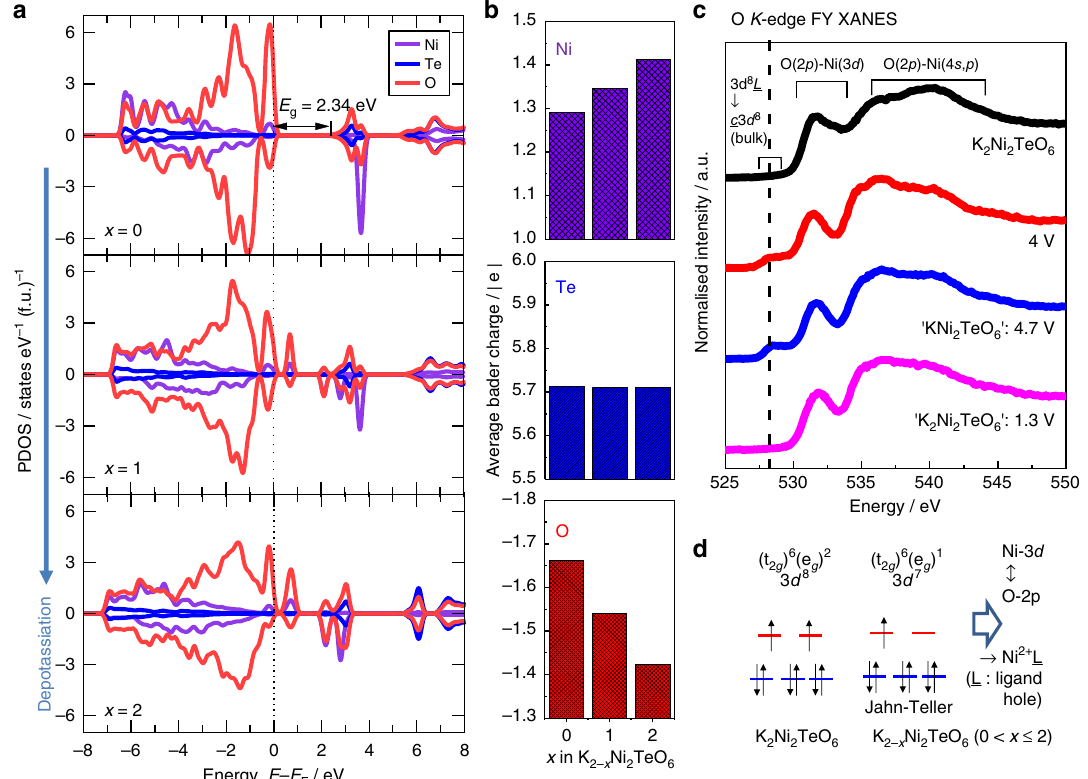
Fig. 5 Theoretical and experimental (spectroscopic) analysis of the electronic structural changes of K 2 Ni 2 TeO 6 during K-ion extraction and insertion. a The computed partial density of states (PDOS) decomposed into the up-spins (positive axis) and down-spins (negative axis) for different composition x in K 2 – x Ni 2 TeO 6 ( x = 0, 1, 2) as function of energy ( E ). The PDOS of the up-spin nickel ( d ↑ 5 d ↓ 3 at x = 0, d ↑ 4.5 d ↓ 3 at x = 1, and d ↑ 4 d ↓ 3 at x = 2) and its directly bonded oxygen atoms are selected. The Fermi level (EF) is set at 0 eV with a vertical black dashed line. PDOS plots indicate a cumulative cationic (Ni 3 d ) and anionic (O 2 p ) redox activity during de-potassiation (K-ion extraction). b Bader charge allocation analysis on the total charge of Ni 3 d , Te 4 d and O 2 p showing unequivocal charge fl uctuations in not only Ni but also O in K 2 – x Ni 2 TeO 6 during K-ion extraction. c Normalised O K -edge ex situ XANES spectra of K 2 Ni 2 TeO 6 cathode during (dis)charging taken in fl uorescence yield (FY) mode, which is highly sensitive to the innate bulk properties of K 2 Ni 2 TeO 6 . Ligand holes are created in the O 2 p bands during K-ion extraction and vice versa during K-ion reinsertion. d Schematic illustration of the electrochemistry of K 2 Ni 2 TeO 6 utilising the ligand hole formation in the hybridised Ni 3 d and O 2 p states during K-ion